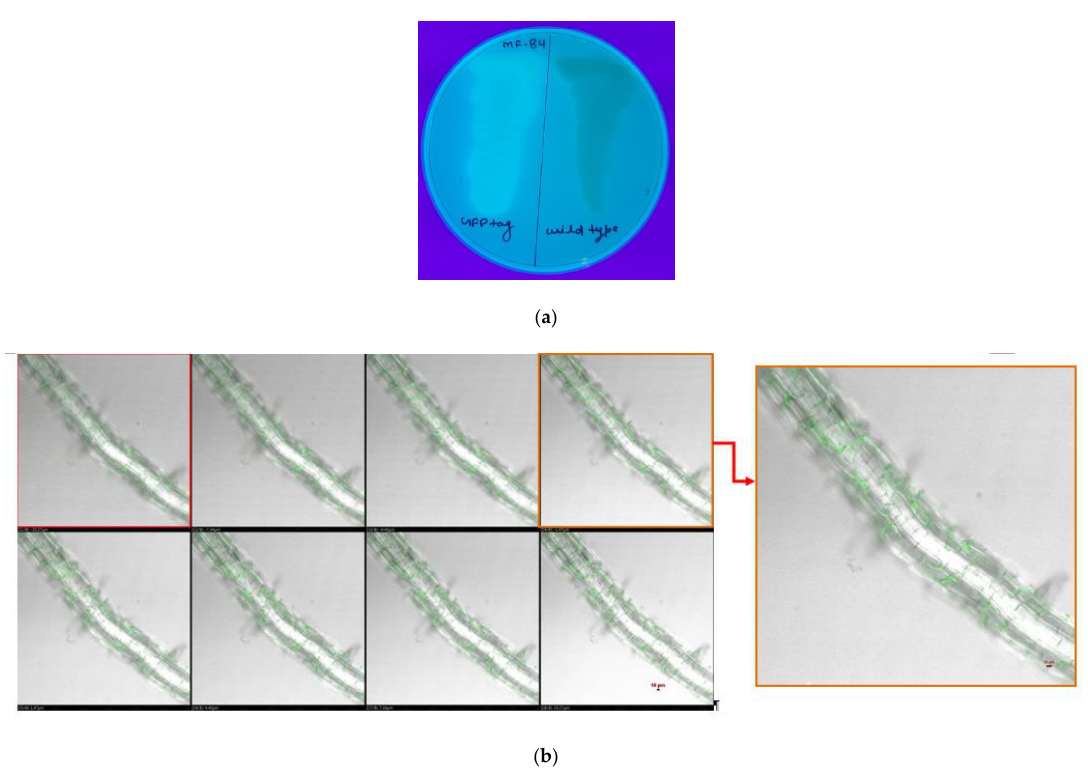
Figure 3. ( a )GFP tagging of Pseudomonas geniculata MF-84; ( b )Visualization of GFP tagged Pseudomonas geniculata MF-84 in the maize roots through Confocal Scanning Laser Microscope (10×).